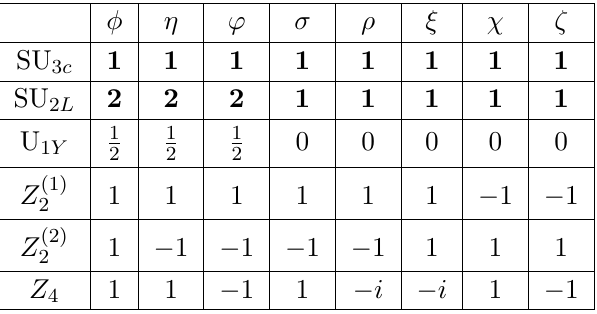
Table 3 . Scalar assignments under SU 3 c × SU 2 L × U 1 Y × Z (1)